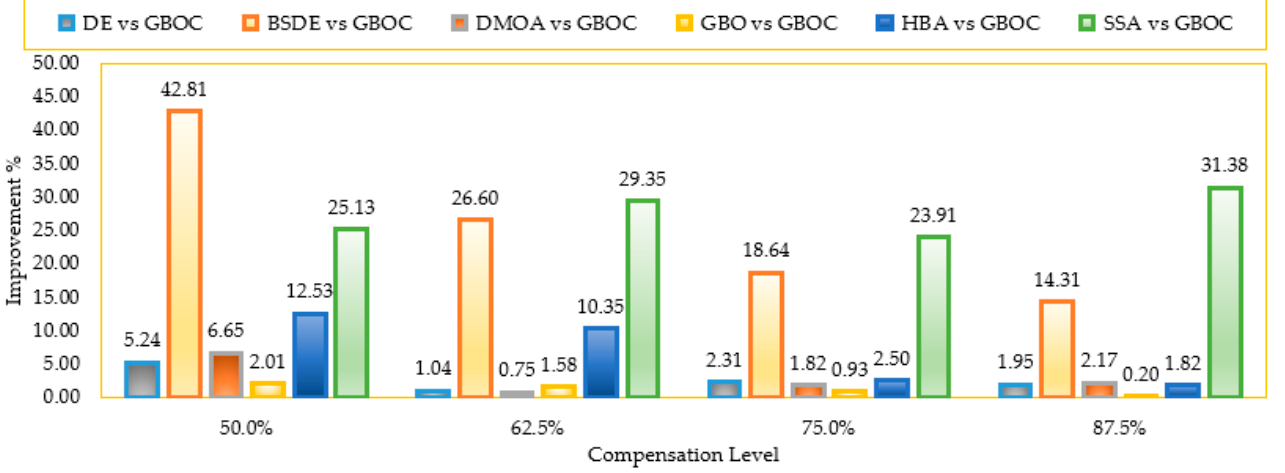
Figure 20. Improvement percentages of the proposed GBOC versus GBO, SSA, DMOA, DE, and HBA for the IEEE 69-distribution system with improved compensation levels.